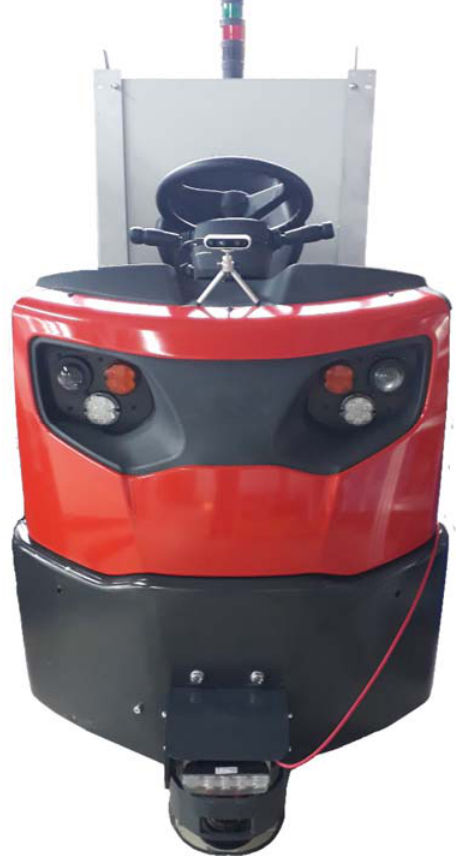
Figure 1. Experimental setup used during this work.